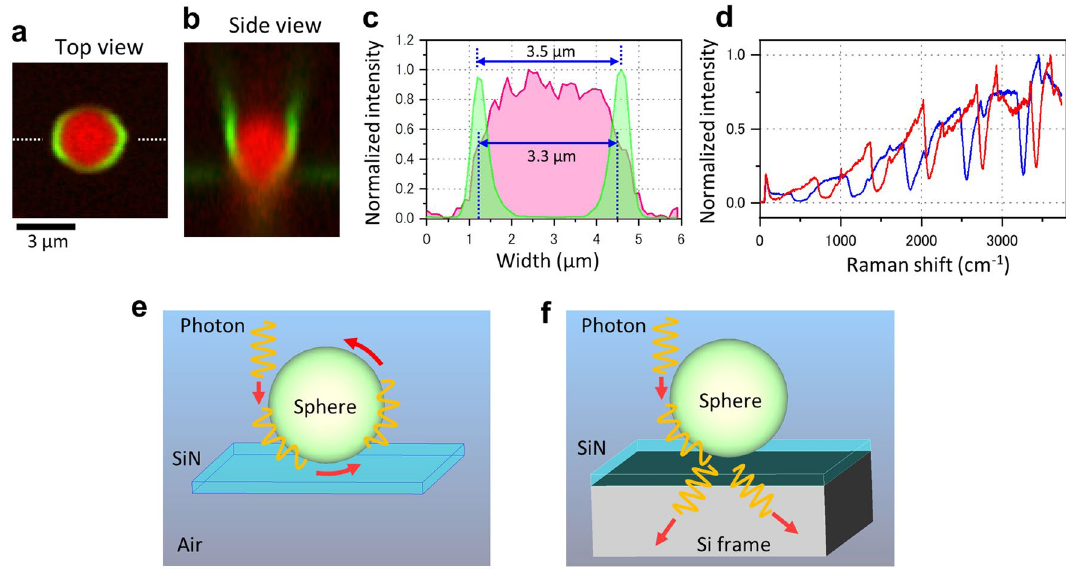
Figure 2. Raman spectra of the sphere circumference on SiN film. ( a , b ) Top and side views of merged Raman images of the PS peak (1006 cm −1 , red) and anomalous peak of 3438 cm −1 (green) with a 3 μm diameter sphere on a 50 nm thick SiN film without contact with a Si frame. The PS sphere is seen to be covered with a ring- shaped anomalous Raman peak. ( c ) Comparison of the line plots of PS peak (1006 cm −1 , red) and 3438 cm −1 (green) at the sphere centre in ( a ). The Raman intensities are normalized individually. The distance between the two half maxima of the PS peak is 3.3 μm and the distance between the peaks at the periphery of the 3438 cm −1 is 3.5 μm. ( d ) Comparison of the Raman spectrum at two sphere circumferences in Fig. 1i indicated by red and blue arrows. Both spectra were of 4 cycles but the phases were different. ( e ) In the spheres on a SiN film, the light continues to circulate without being affected by the film. ( f ) In the spheres on a SiN film directly on a Si frame, the orbiting light is scattered and lost due to the influence of the Si frame. Scale bar, 3 μm in ( a